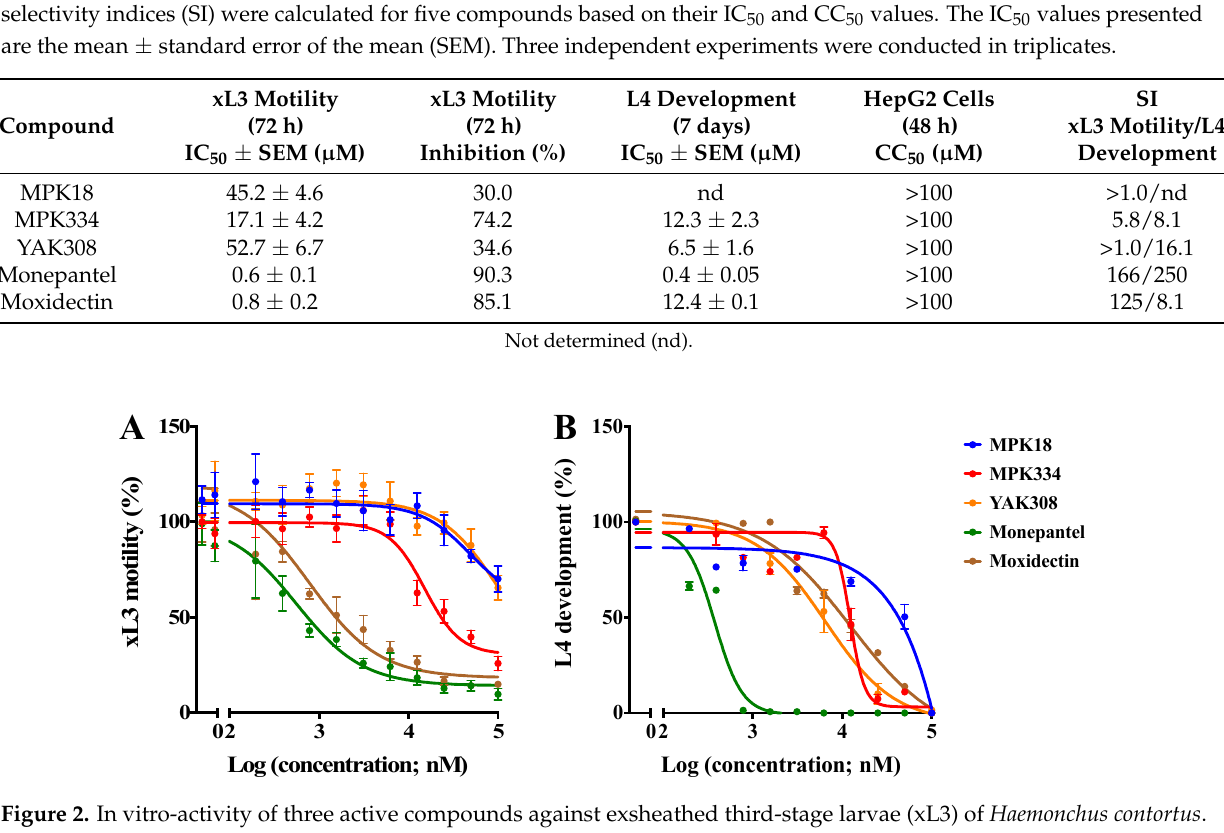
Figure 2. In vitro-activity of three active compounds against exsheathed third-stage larvae (xL3) of Haemonchus contortus . Dose-response curves of the individual compounds (MPK18, MPK334 and YAK308) and two control compounds (monepantel and moxidectin) assessing the inhibition of xL3-motility at 72 h (panel A) and larval development over seven days (panel B). Data points represent three independent experiments conducted in triplicates; the mean ± standard error of the mean (SEM).